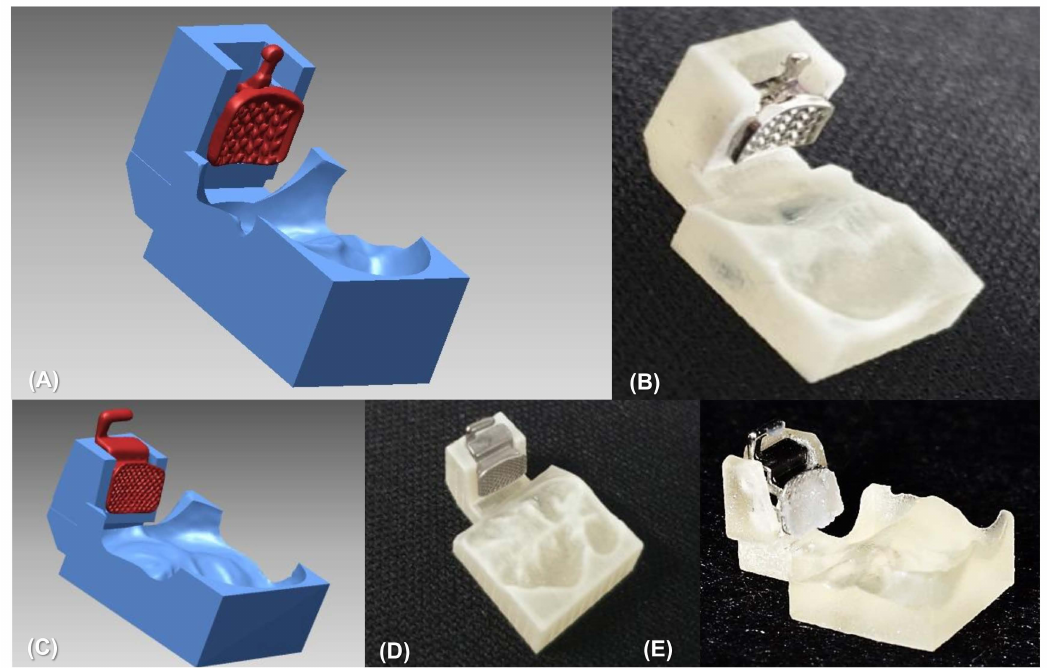
Figure 1. One-body transfer jig system based on CAD/CAM technology for indirect bonding. ( A ) An example of a transfer jig design for a premolar. ( B ) Manufactured transfer jig by three-dimensional printing technology. ( C ) Virtual design of transfer jig for a molar. ( D ) Bracket transfer jig precisely implemented with three-dimensional printing technology. ( E ) A customized resin base was formed through additional laboratory